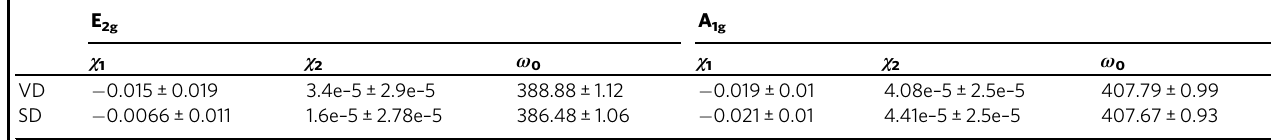
Table 1 Temperature coef fi cients of Raman